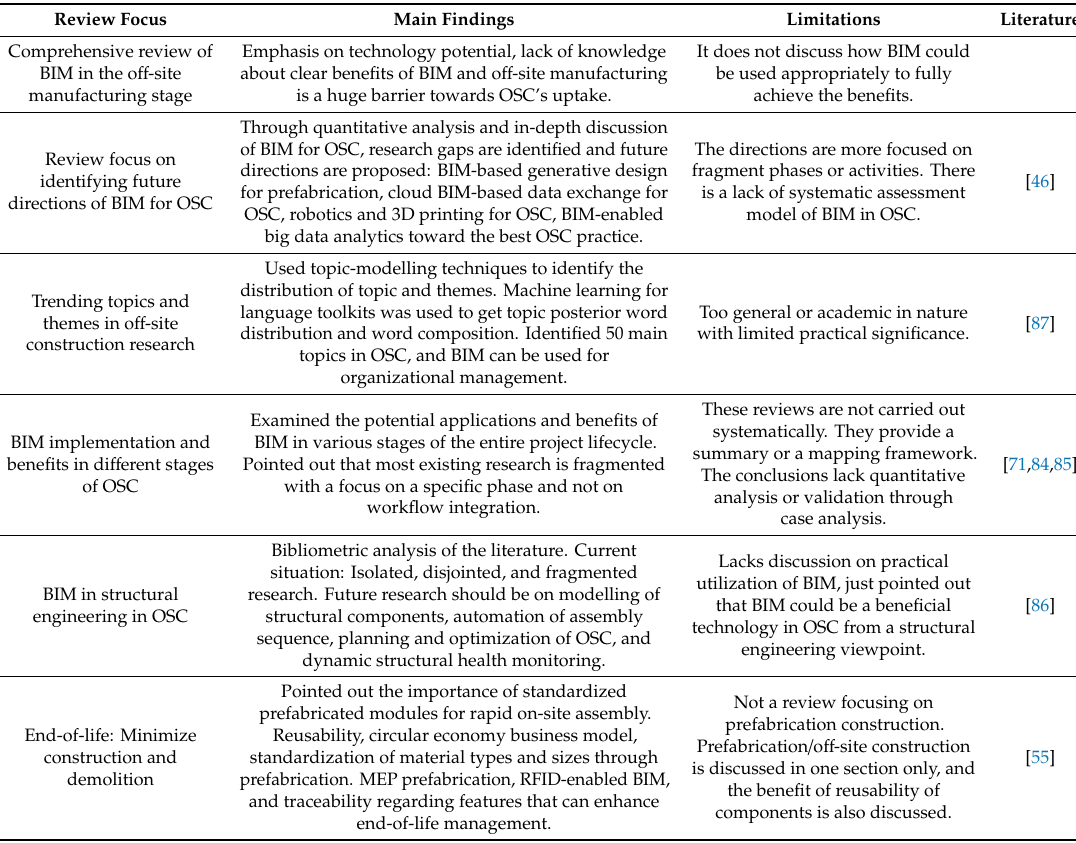
Table 3. Summary of the eight review papers of BIM in